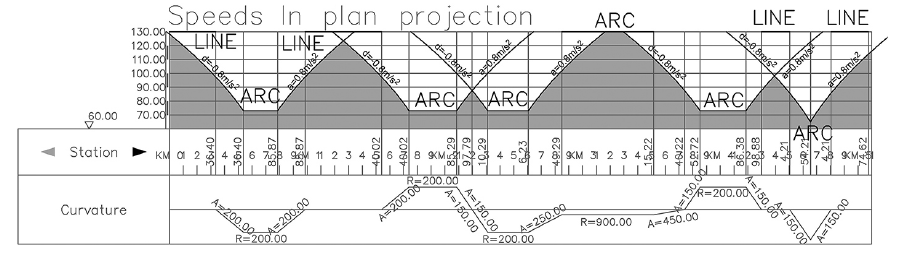
Fig. 6. Calculating operating speed levels in plan projection